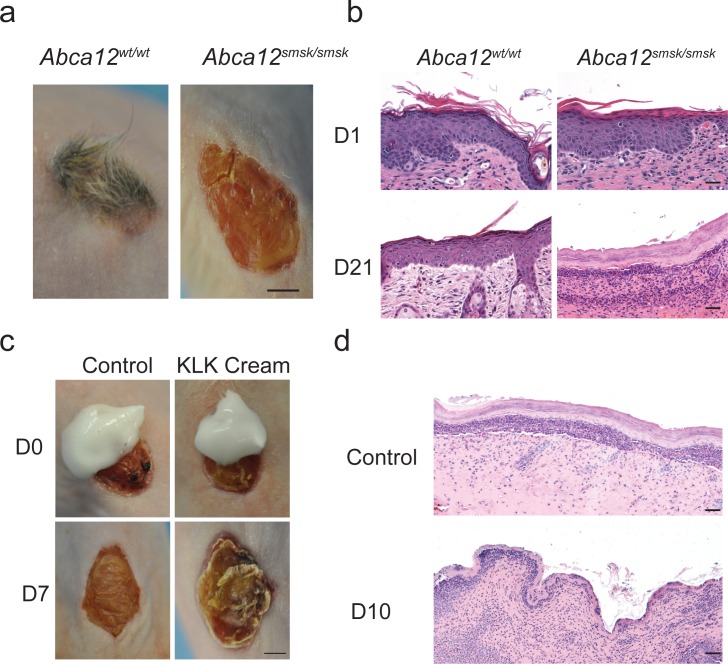
Transplant of Abca12smsk/smsk skin grafts.(a) Back skins of E18.5 WT and Abca12smsk/smsk embryos were transplanted onto nude mice. Bar = 2 mm. (b) Histological presentation of H&E stained sections of the grafts from WT and smsk transplanted skin. Note the loss of normal epidermal architecture at the end of 3 wks of transplantation in the smsk grafts. Bar = 50 μm. (c) Smsk E18.5 skin grafts were treated daily with a cream containing either the recombinant KLKs or the digestion buffer (Control). Shedding of the top layers of the hyperkeratotic skin grafts was observed only in grafts treated topically with KLK cream. Images were taken after 7 days of treatment. Bar = 2 mm. (d) Representative H&E images are shown of control and KLK cream treated smsk mutant skin grafts. Bar = 10 μm.